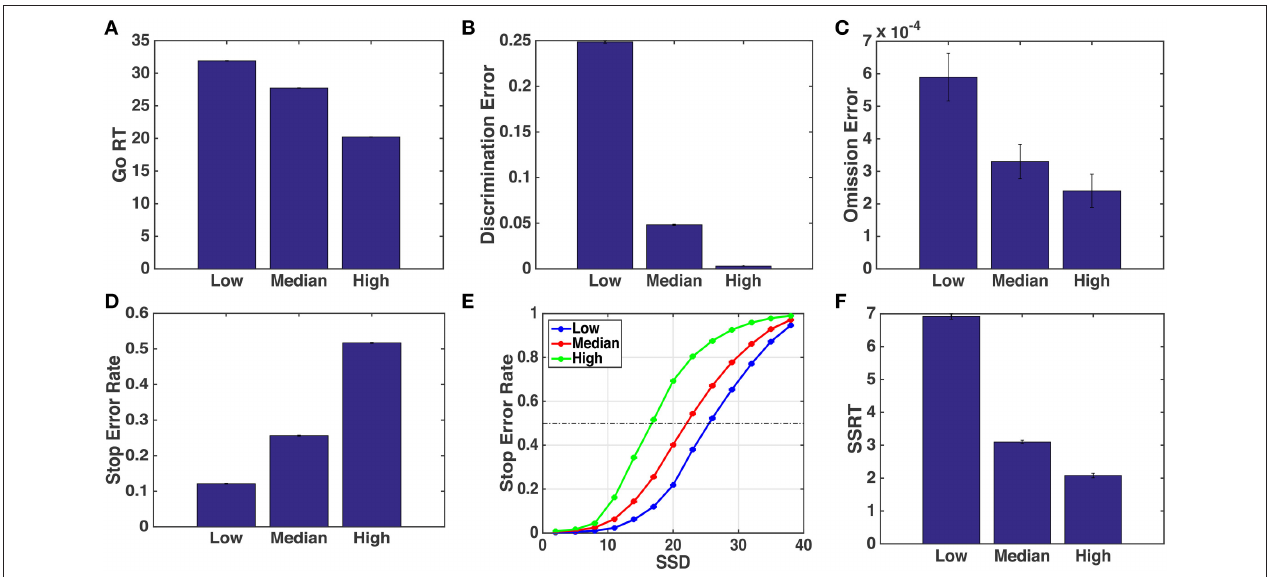
FIGURE 4 | Simulated behavioral predictions by the optimal decision-making model. (A) Simulated mean Go RT decreases with higher go stimulus coherence (easier discrimination). Low , median , and high stimulus coherence are parameterized by different values of q d : 0.55, 0.62, and 0.70, respectively. (B) Discrimination error rate decreases as coherence increases. (C) Omission error rate decreases with q d . (D) Stop error rate increases with the q d . (E) Average stop error rate as a function of SSD (known as the inhibition function ) for different stimulus conditions. (F) SSRT decreases with q d . Each data point is averaged over 100 simulated subjects, each performing 1000 go or stop trials. Error bars indicate standard error of the mean (sem); sem is extremely small and almost invisible for all but the omission error simulation data. Other parameters used in the model are adapted from Shenoy and Yu (2011): r = 0.25 , q s = 0.72 , D = 50 , c s = 0.4 , c = 0.002 .